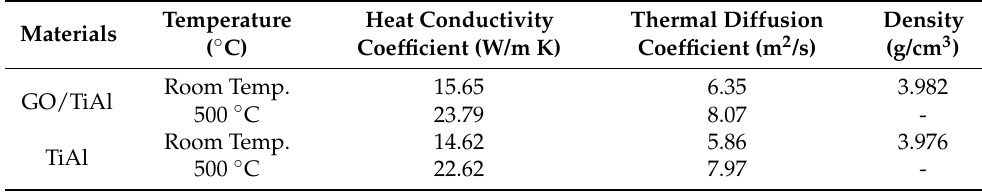
Table 1. Physical properties of the TiAl and